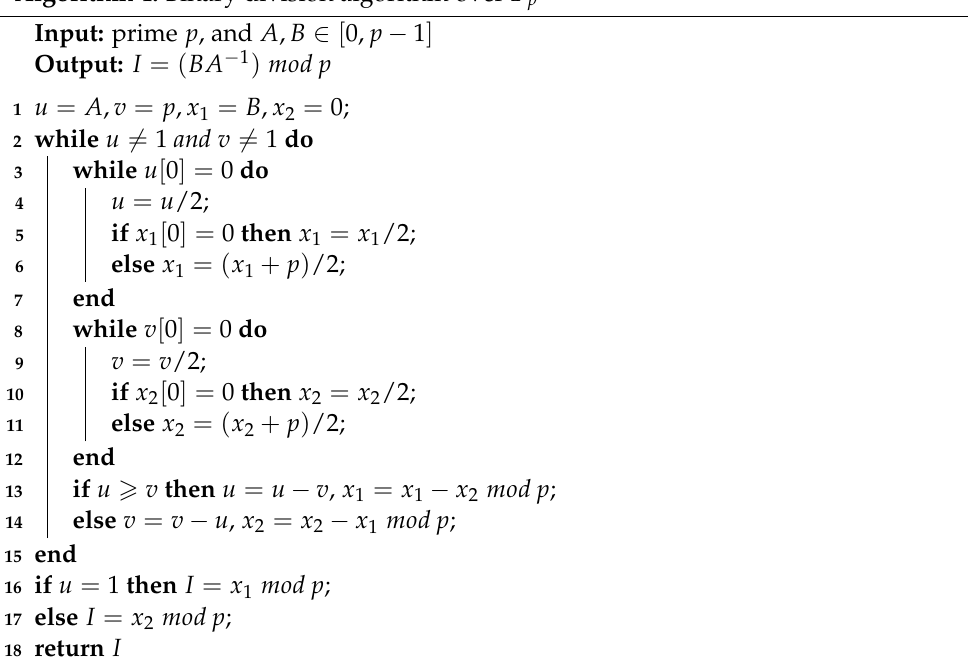
Algorithm 4: Binary division algorithm over F